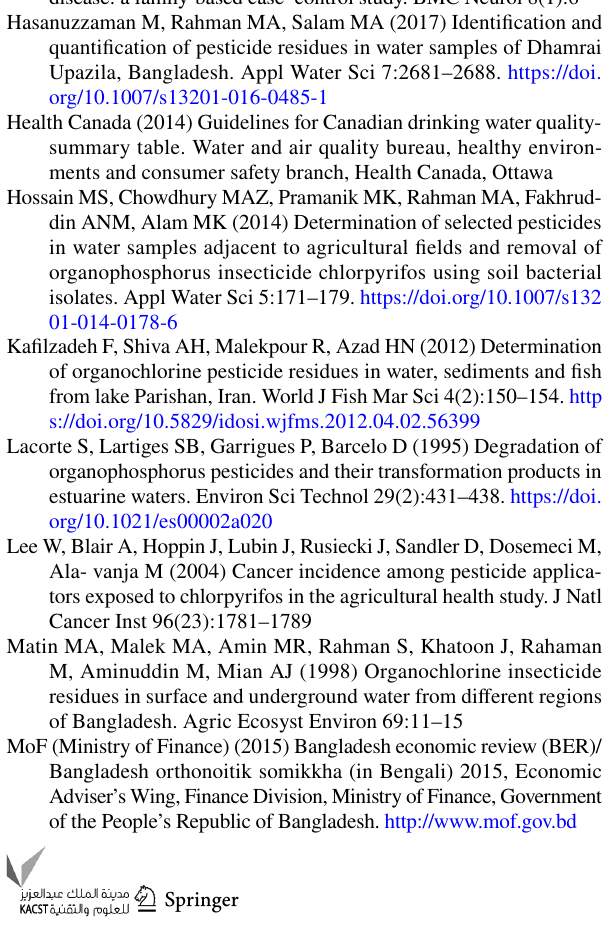
summary table. Water and air quality bureau, healthy environ- ments and consumer safety branch, Health Canada, Ottawa Hossain MS, Chowdhury MAZ, Pramanik MK, Rahman MA, Fakhrud- din ANM, Alam MK (2014) Determination of selected